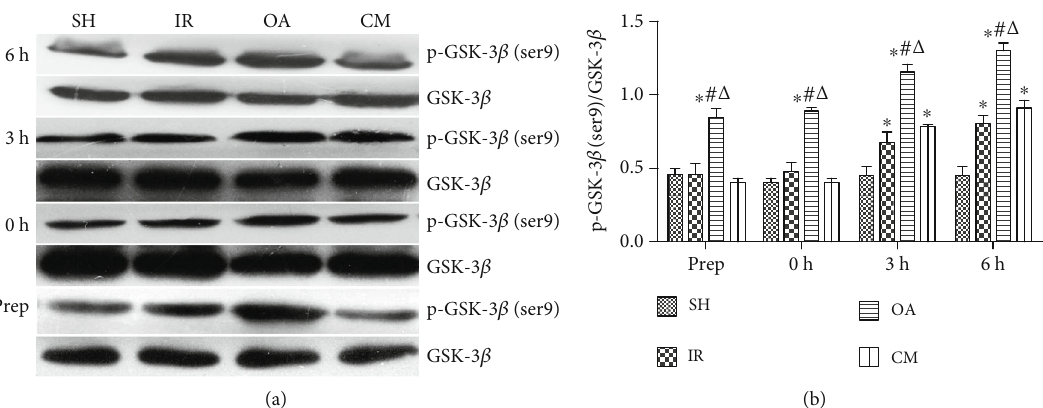
Figure 1: E ff ects of pretreatment with OA on p-GSK-3 β (ser9) and GSK-3 β protein expression in rats induced by partial hepatic ischemia- reperfusion (IR). Expression of p-GSK-3 β (ser9) and GSK-3 β protein was detected by western blot analysis (a). These bands were quanti fi ed and analyzed (b). Data are represented as mean ± SD ( n = 8 ). ∗ P < 0 : 05 , compared with group SH. # P < 0 : 05 , compared with group IR. Δ P < 0 : 05 , compared with group